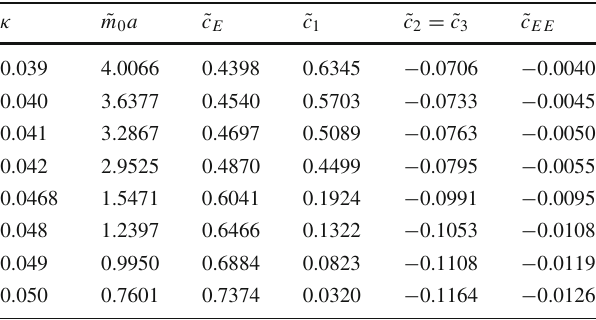
Table 2 Values for the couplings in the OK action, computed from the input hopping parameters in Table 1, the critical hopping parameter κ = 0 . 05354, and the tadpole factor u = 0 . 8688. The errors on crit 0 κ crit and u 0 are unimportant for this study and, thus, neglected. Our code evaluates the improvement coefficients directly from the tree-level matching result as described in the text. Here, we present truncated values. The OK couplings ˜ c B = r s = 1, ˜ c 4 = 9 / 24, and ˜ c 5 = 1 / 4 do not depend on the quark mass ˜ m 0